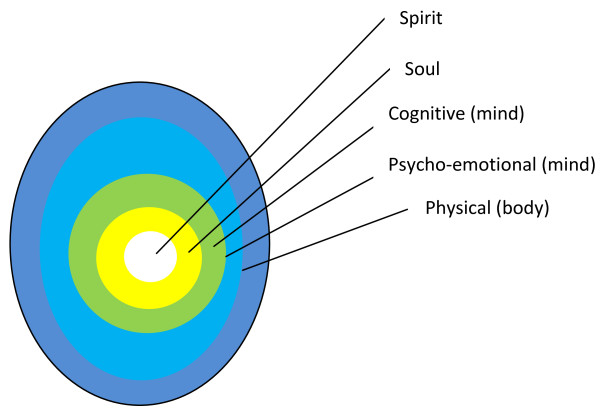
The seed of life model (SOLM). The SOLM proposes a dualistic configuration of the human nature comprising the physical and spiritual spheres The egg-like model shows the relationship of different domains of quality of life as onion-like concentric zones within two spheres. The physical sphere (peripheral) includes the physical (body), psycho-emotional (mind) cognitive domains (mind) domains while the spiritual sphere (central) includes the soul and spirit domains.